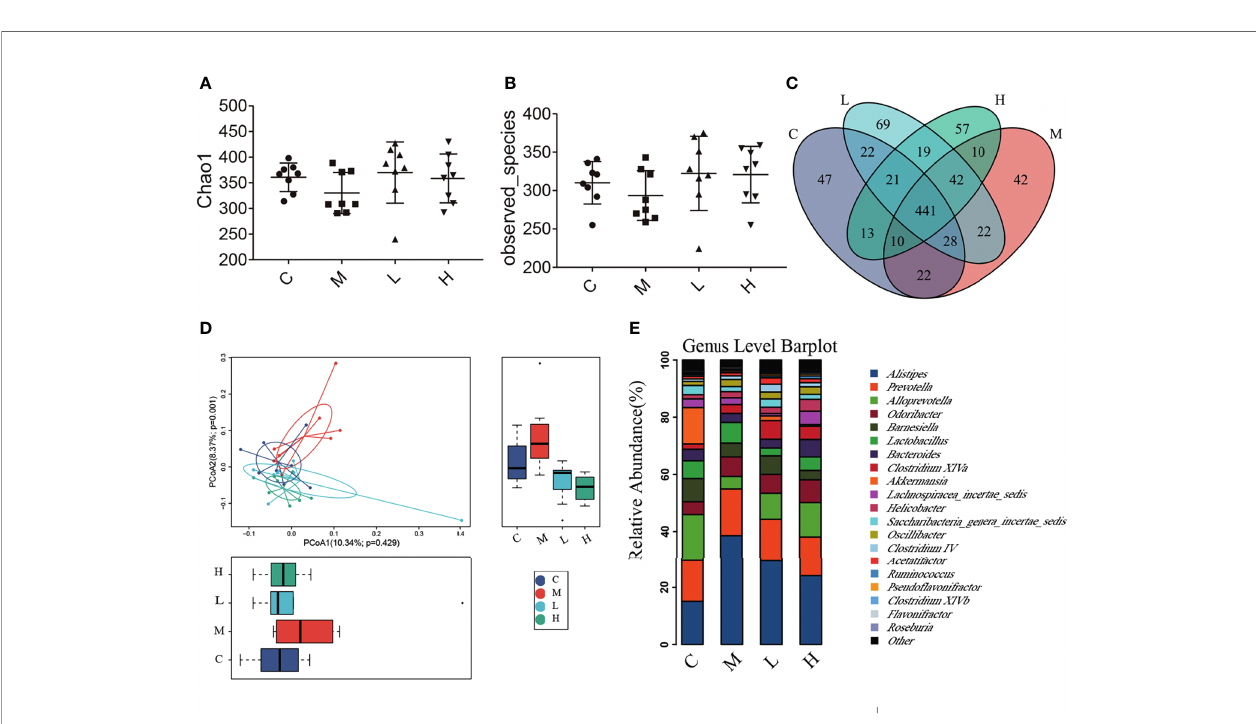
FIGURE 5 | The probiotic combination altered the gut microbiota composition of SAMP8 mice. (A) The Chao1 index. (B) The Observed_species index. (C) The Venn diagram. (D) The PCoA analysis. (E) Species abundance analysis at the genus level. C, control group (n = 8); M, model group (n = 8); L, low-dose probiotics group (n = 8); H, high-dose probiotics group (n = 8). Data are presented as the means ±